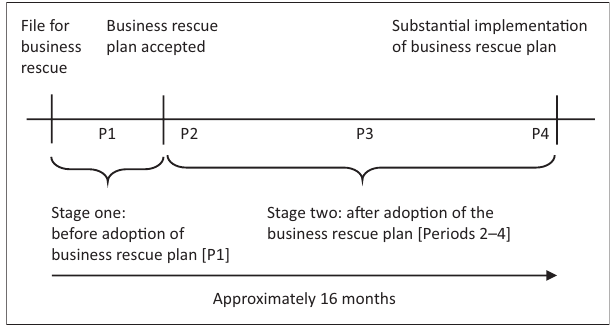
FIGURE 2: Business rescue duration and stages of